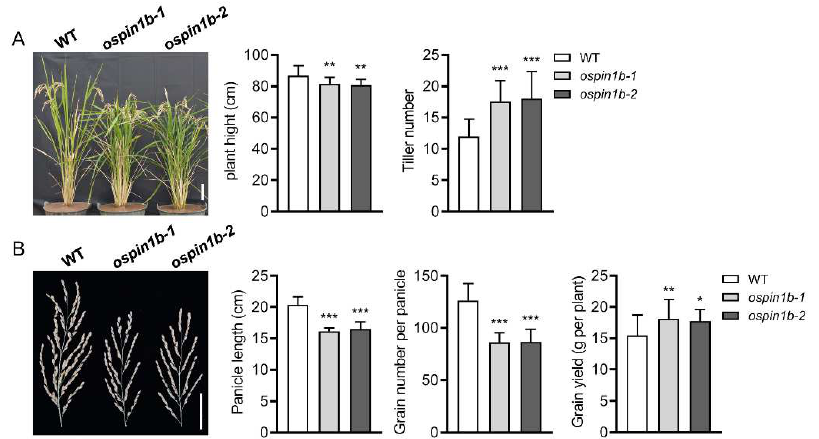
Figure 7. Phenotypes of wild-type (WT), ospin1b-1 and ospin1b-2 at the mature stage. ( A ) Plant height and tiller number. The plants were grown in the field and transferred to different plastic pots for photo shoots. Bar = 10 cm. ( B ) Panicle length, grain number per plant and grain yield per plant. Bar = 5 cm. Values are means ± standard deviation (SD) ( n = 24). Data were analyzed by ANOVA and Tukey’s tests. *: p < 0.05; **: p < 0.01; ***: p < 0.001.